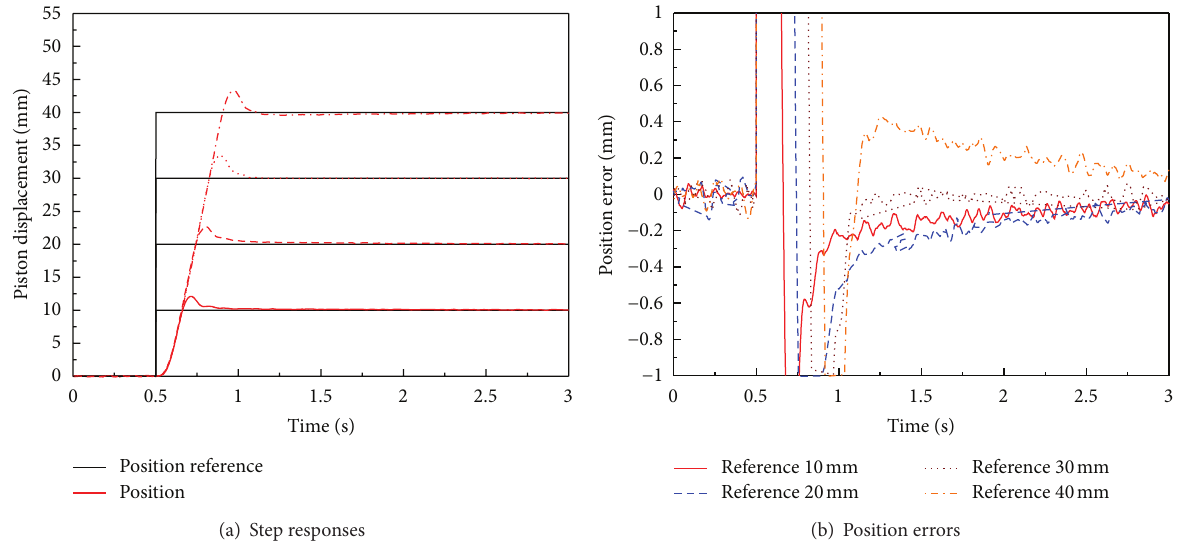
Figure 12: Saturation of BLDC motor for optimal PID position control system for EHA without load disturbance (only mass load is applied).